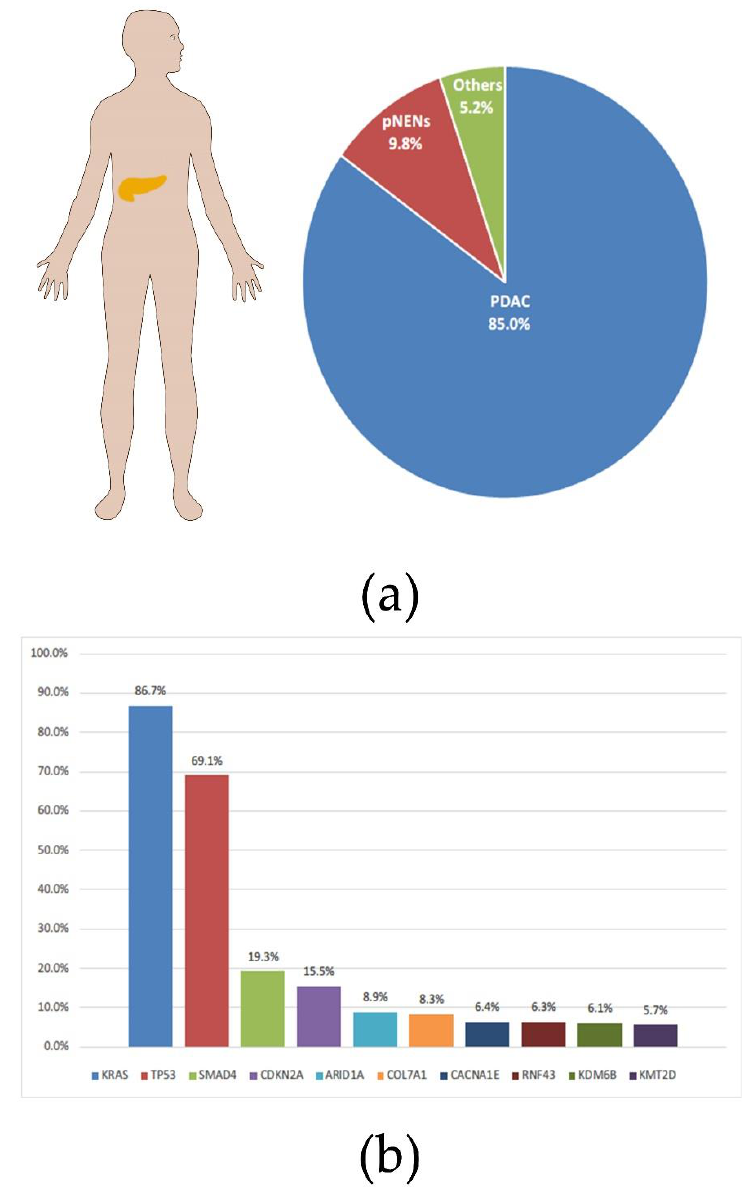
Figure 1. Percentage of pancreatic cancer by type and the probability of related mutations. ( a ) The proportion of main subtypes in pancreatic cancer. ( b ) Frequencies of mutations in individual genes contained in PDAC. All charts were constructed based on data from AACR Project GENIE: Powering Precision Medicine through an International Consortium (GENIE Cohort v11.0-public [8]).